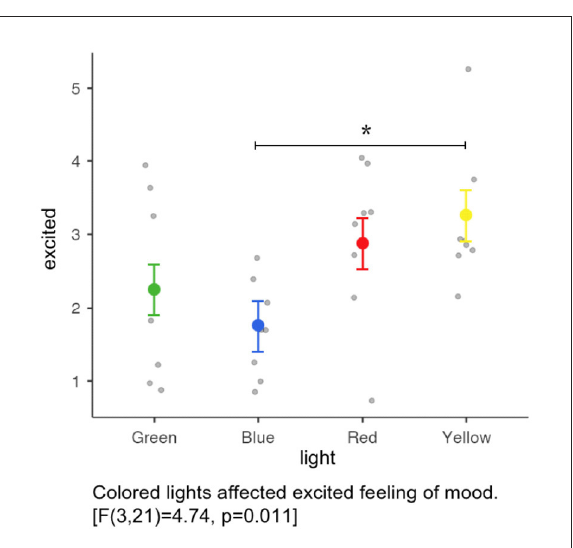
FIGURE5 Result of participants’ excited mood in experiment 1. * p <